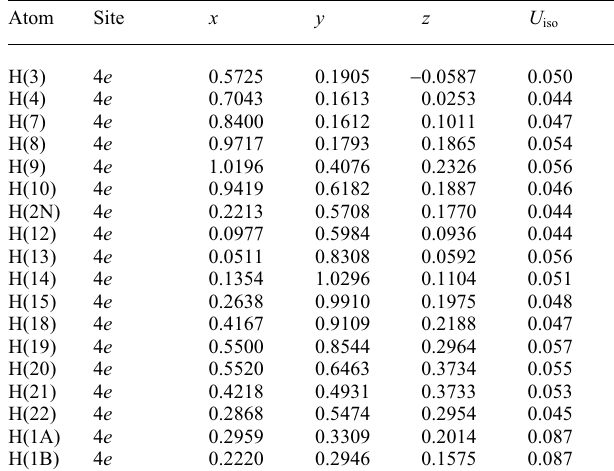
Table 1. Data collection and